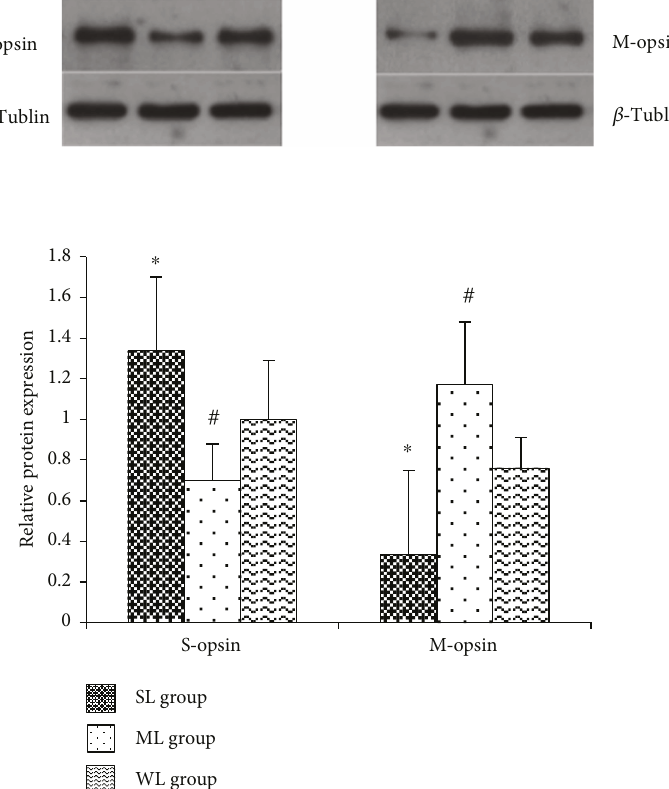
Figure 5: S- and M-opsin protein expressions in the retinas of guinea pigs illuminated by short-wavelength light, middle-wavelength light, or white light (represented as a bar graph). Expressions of S-opsins in the retinas of guinea pigs in the SL group were signi fi cantly higher than those in the ML group ( p < 0 05 ) while expressions of M-opsins in the retinas of guinea pigs in the SL group were signi fi cantly lower than those in the ML group ( p < 0 05 ). SL: short-wavelength light; ML: middle-wavelength light; WL: white light. ∗ means signi fi cant di ff erences between the SL and WL groups. # means signi fi cant di ff erences between the ML and WL